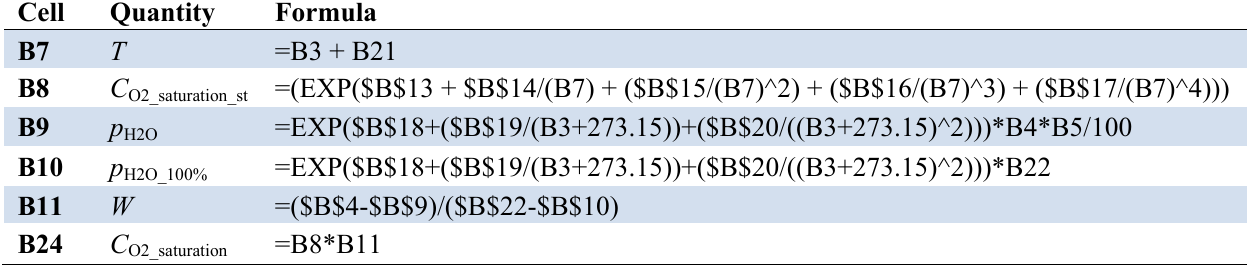
Table A2. Formulas needed for calculation of DO saturation concentrations described in Table A1.